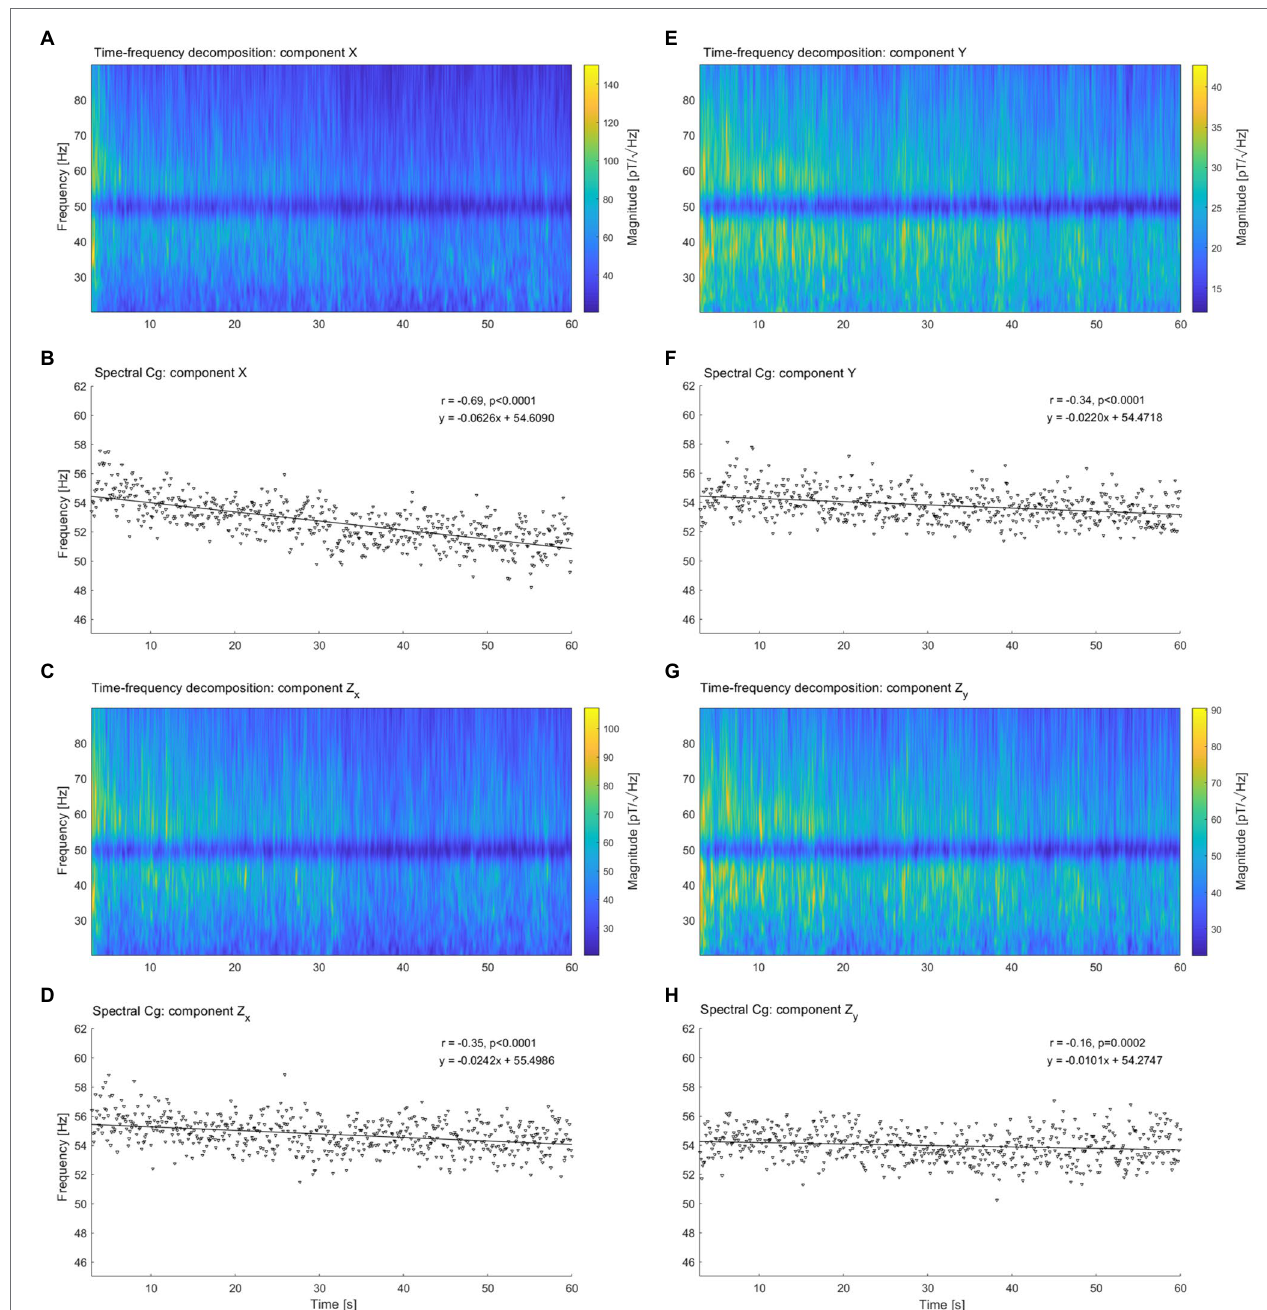
FIGURE 2 | Spectral decomposition and spectral center of gravity of Optically Pumped Magnetometer Magnetomyography (OPM-MMG) vector components. (A) Spectral decomposition of component X, (C) Component Z X , (E) Component Y, and (G) Component Z Y . Time on the x-axis from 0 to 60 s, frequency range on the y axis from 20 to 90 Hz. Color bar depicting frequency magnitude. Scaling not match between the figure for visualization purposes, note that frequency magnitude of component X is one order of magnitude higher than component Y. Line noise signal suppression visible at 50 Hz. (B) Spectral center of gravity of component X, (D) Component Z X , (F) Component Y, and (H) Component Z Y . Each triangle represents a spectral center of gravity calculate for one of the 100 ms sliding time window utilized in the time- frequency analysis. Pearson’s r, point of intercept, and slope of the regression line quantified the spectral shift of the magnetomyographic signal over